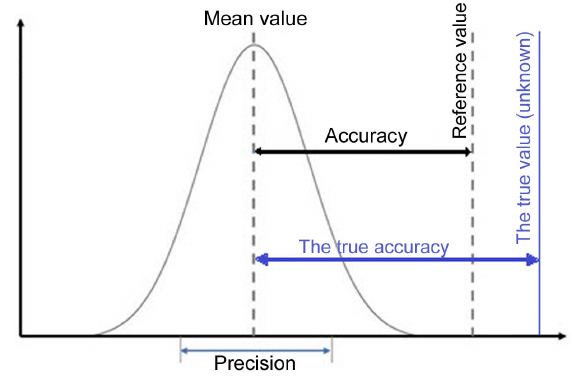
Figure 6 Definition of accuracy and